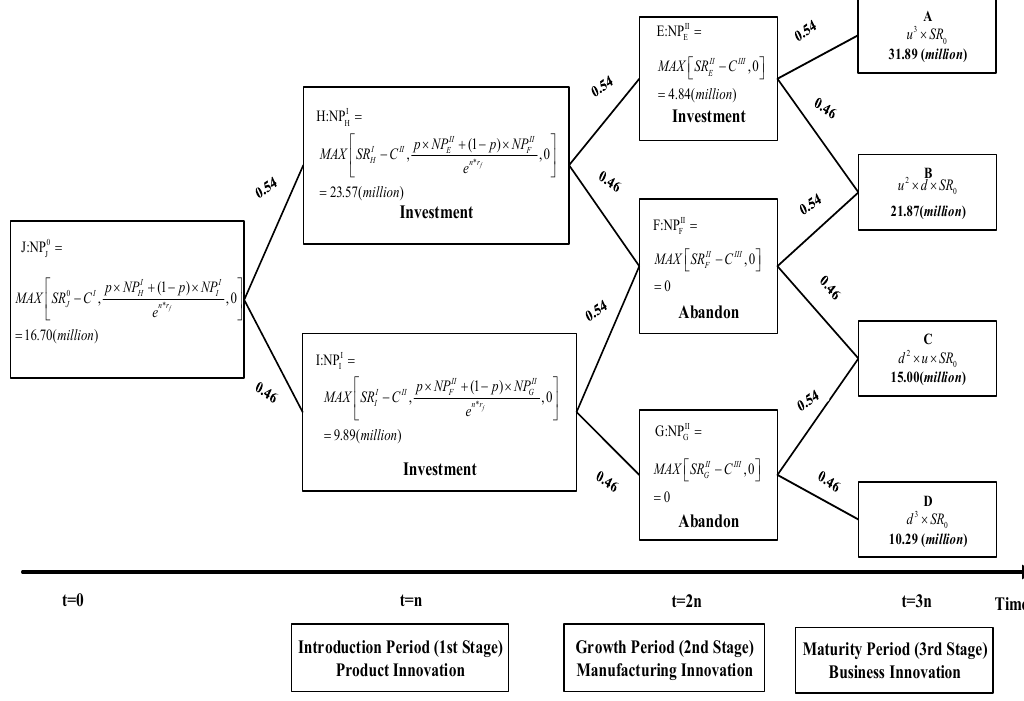
Figure 7. Compound options decision-making tree ( 0.68% r ).